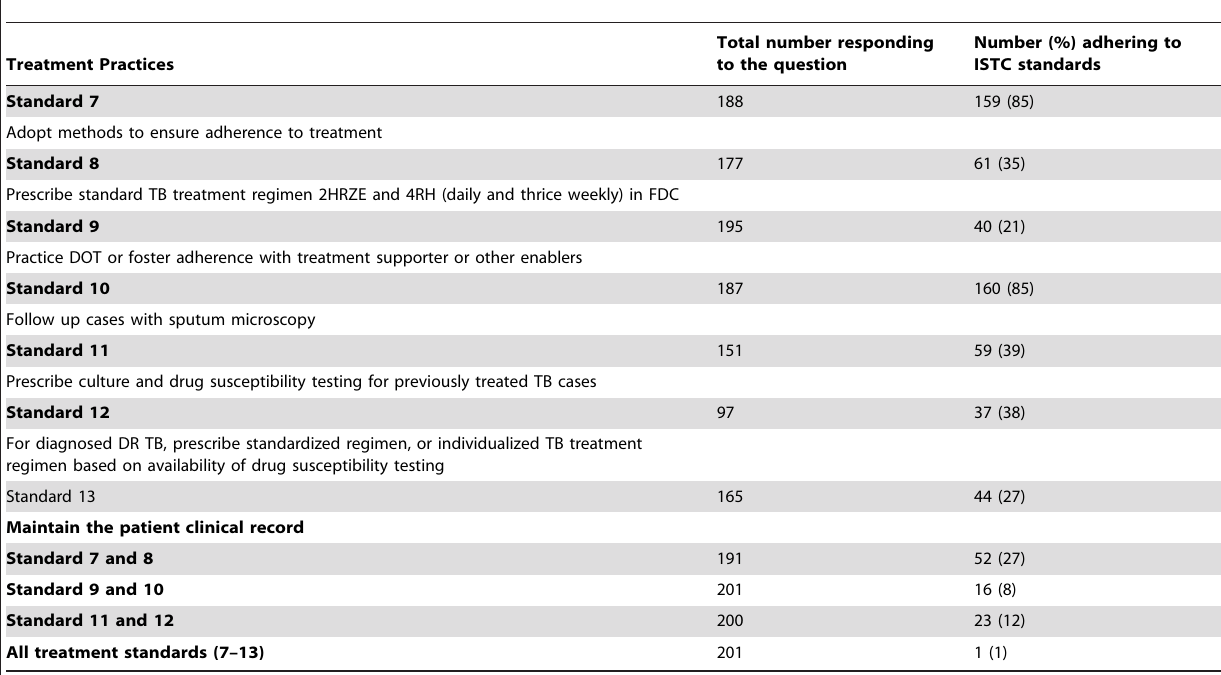
Table 3. Private Practitioners adhering to ISTC * treatment practices in Visakhapatnam, Andhra Pradesh.